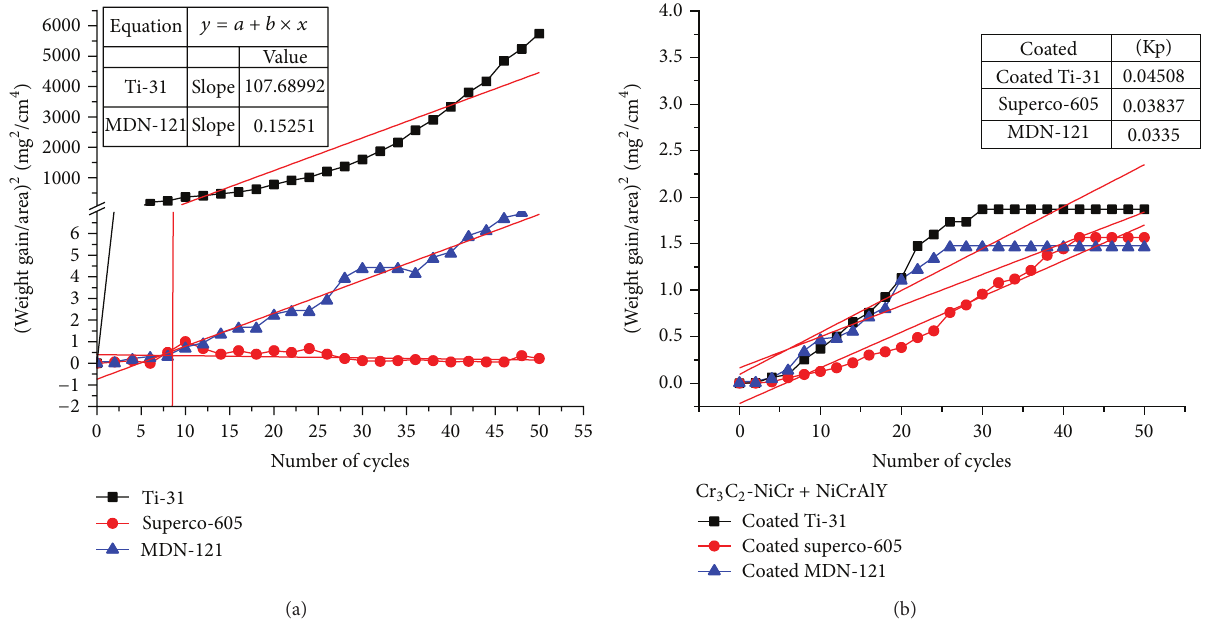
Figure 8: Plot of (weight gain/area) 2 versus number of cycles for coated samples subjected to hot corrosion for 50 cycles in Na 2 SO 4 -50%V 2 O 5 environment at 800 ∘ C. (a) Uncoated samples, (b) 25% (Cr 3 C 2 -25(Ni20Cr)) + NiCrAlY coated substrates. Multiplication factor for 𝐾 10 −8 g 2 cm −4 s −1